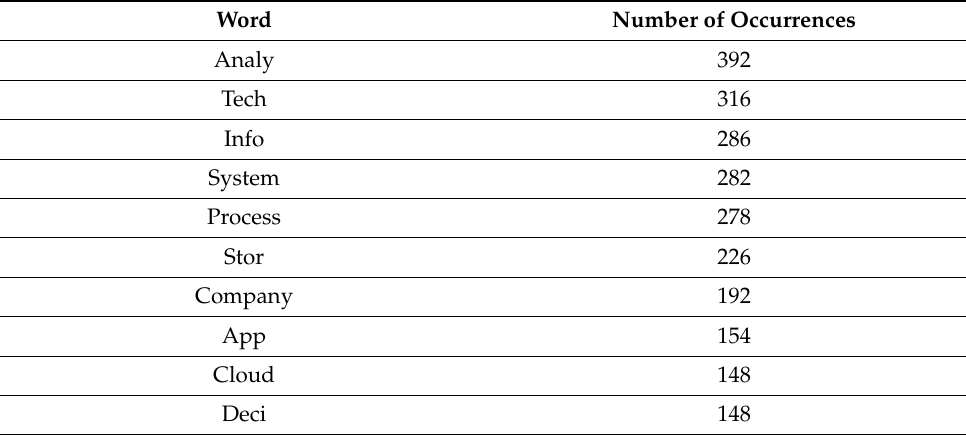
Table 2. Ten most significant words related to big-data management.